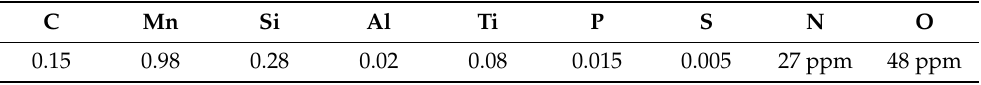
Table 1. The chemical composition of the experimental steel in this study